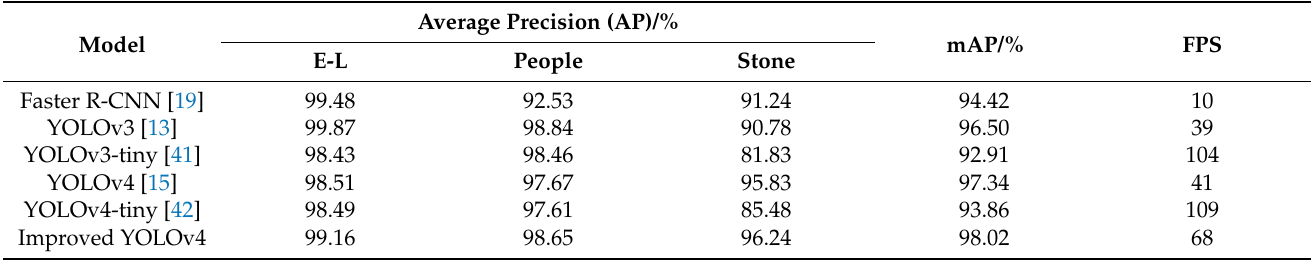
Table 5. Comparative experimental results for different target detection